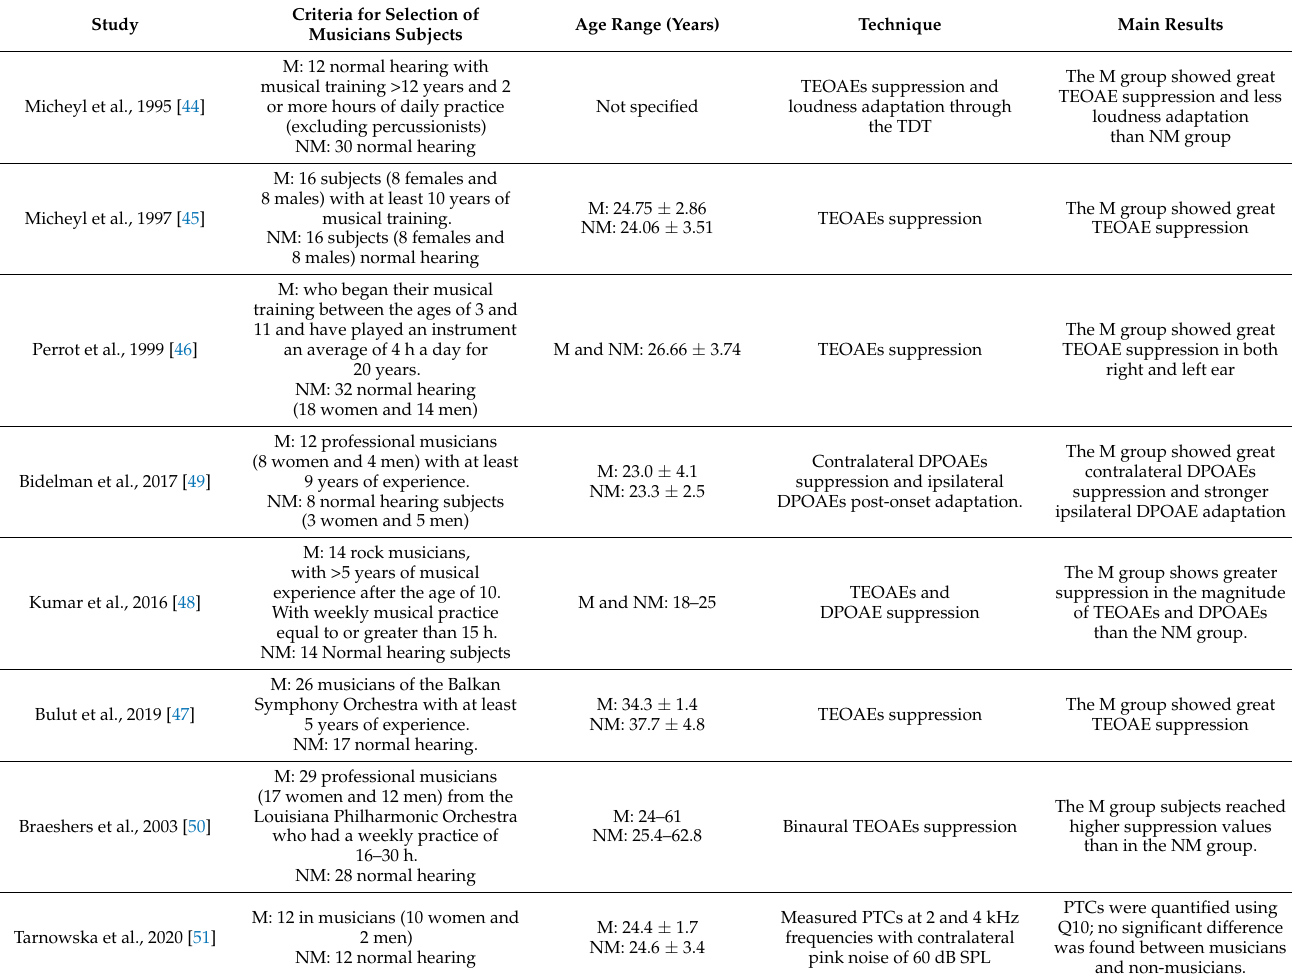
Summary table of reviewed studies sorted by year of publication: Glossary: TEOAEs: Transient otoacoustic emis- sions, DPOAEs: Distortion product otoacoustic emissions M: Musicians, NM: Non-musicians, PTCs: Physiological tuning curves, TDT: Tone decay